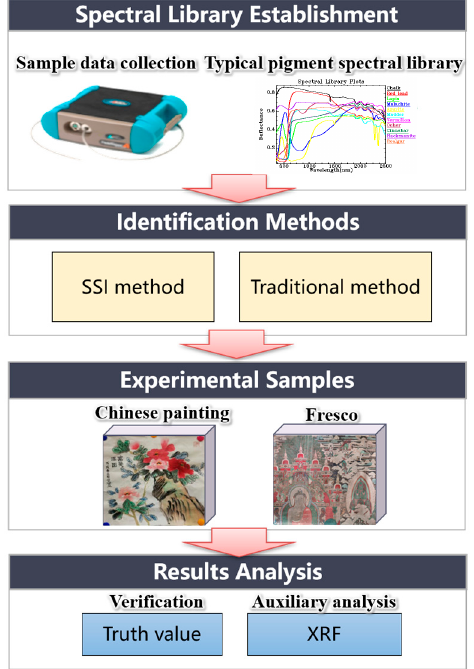
Figure 1. The overall process of the study (SSI, spectral subsection identification (SSI) method considering ion absorption characteristics; XRF, X-ray fluorescence).